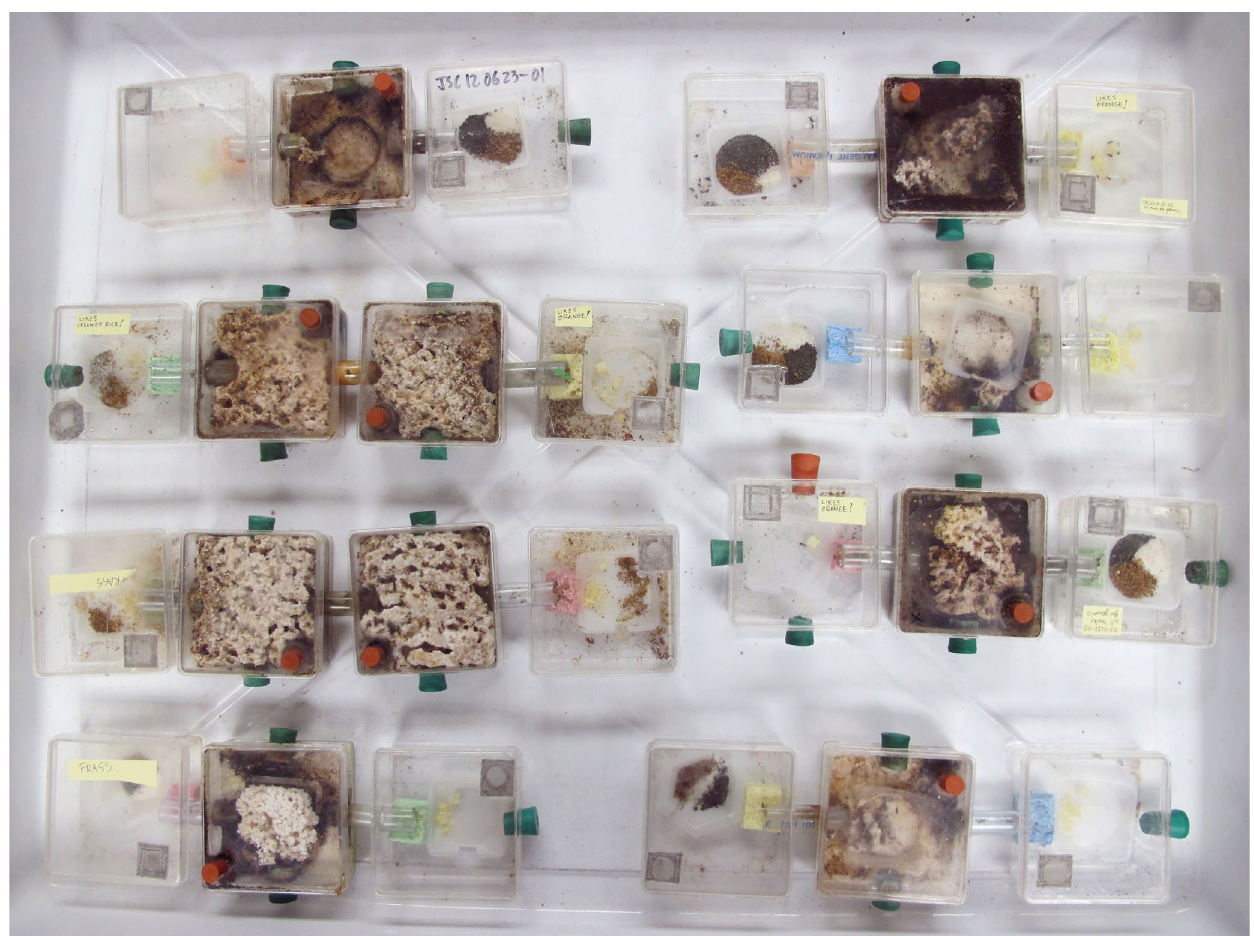
Fig 9. Non-leaf-cutting fungus-farming ant colonies maintained in the NMNH Ant Lab. The nests are arranged in a 20 inch x 24 inch photo- developing